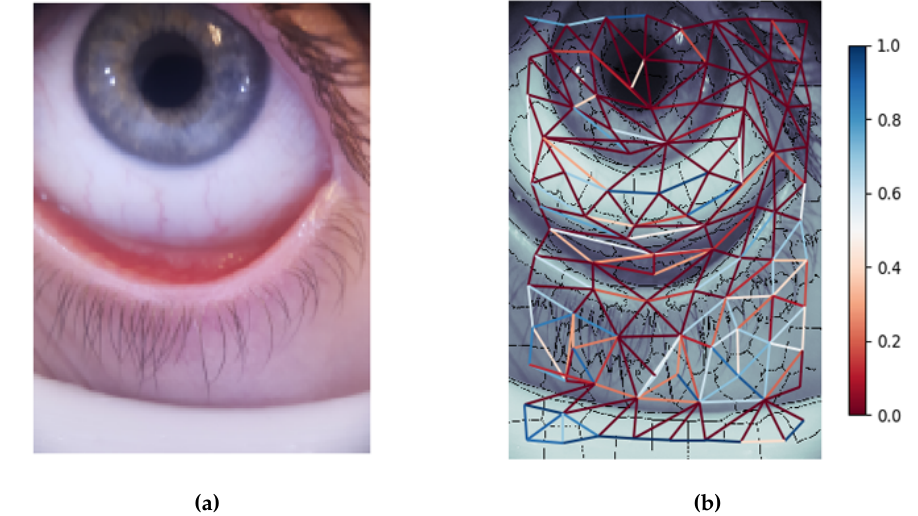
Figure 4. ( a ) Acquired sample; ( b ) region adjacency graph (RAG) displaying a measure of similarity between each region. The center of each node is considered a vertex. For each connection between two regions, there is an associated colored line according to the measure of